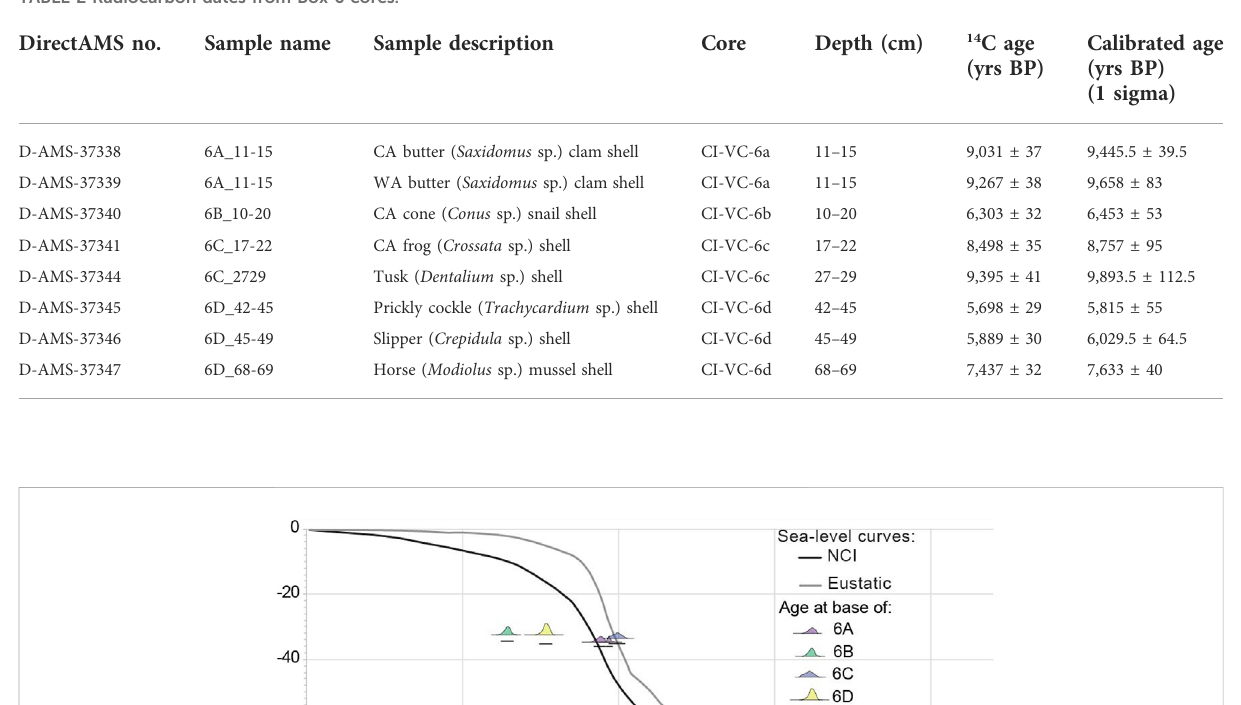
TABLE 2 Radiocarbon dates from Box 6 cores.